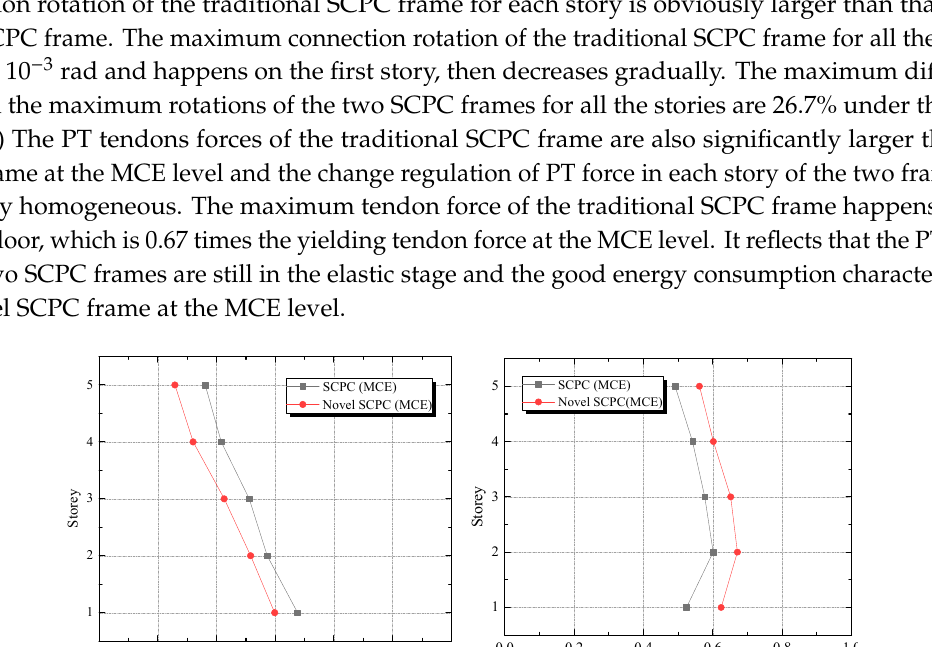
Figure 27. Maximum connection rotation and standardized PT force of two SCPC frames.